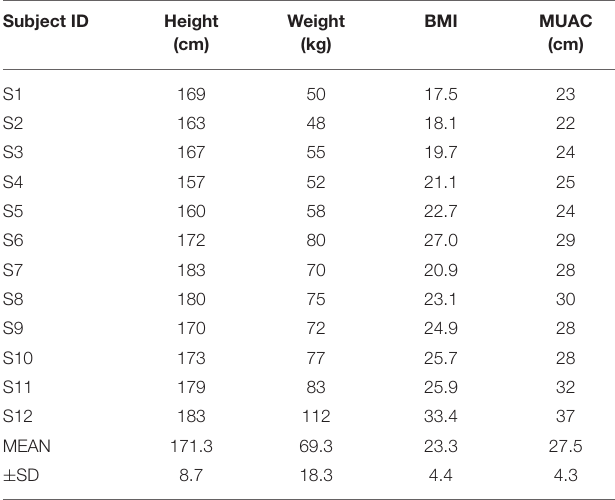
TABLE 1 | Information on our 12 subjects with their body mass index (BMI) and mid-upper arm circumference